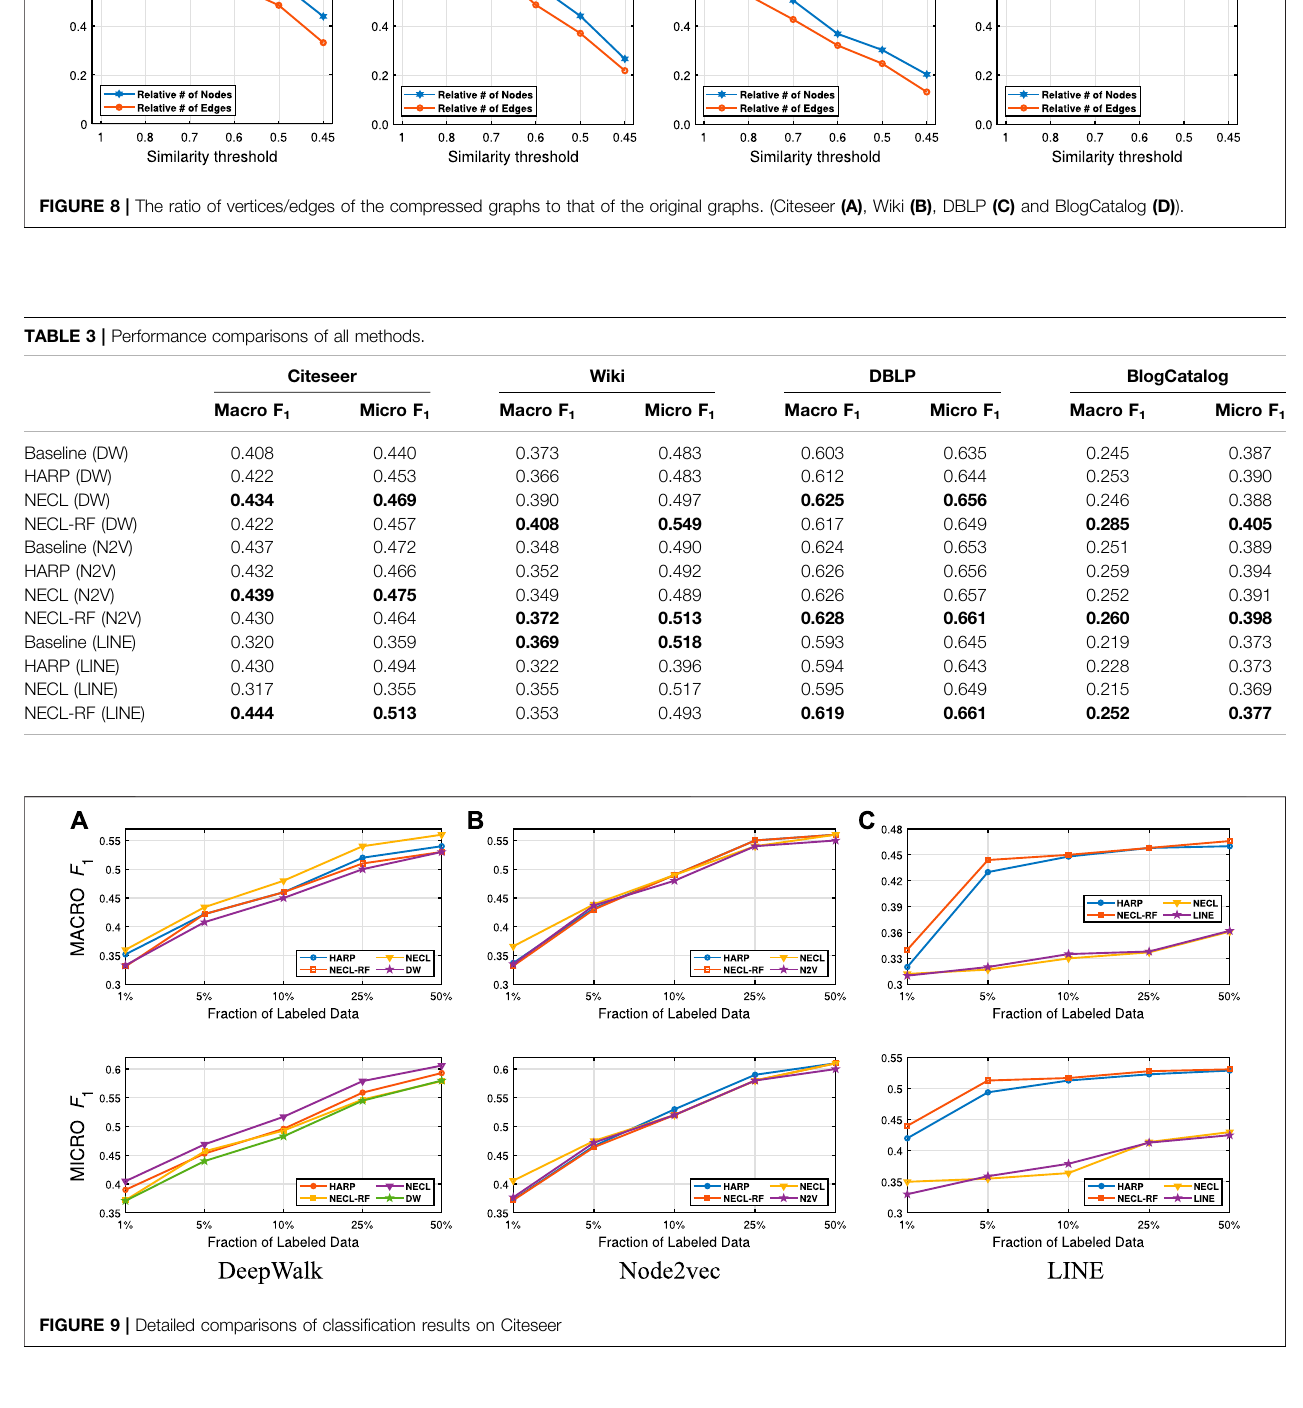
Frontiers in Big Data |